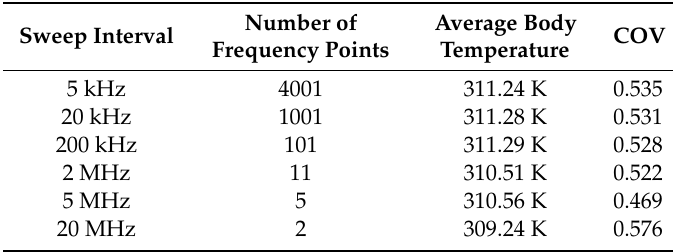
Table 6. Simulated heating results for di ff erent sweep intervals.